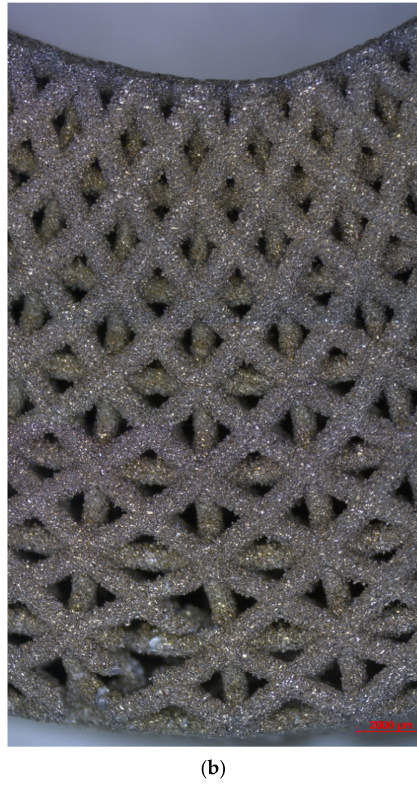
Figure 11. Shear stress vs. shear strain data points for the diagonal scaffold.